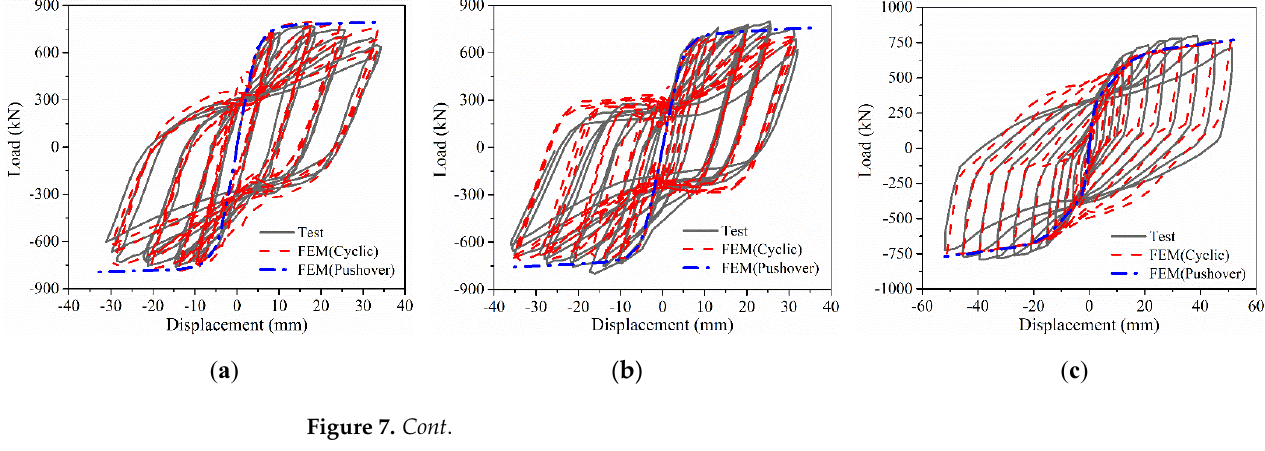
Figure 6. Specimen finite element model: ( a ) SPSW − HS2; ( b ) SPSW − HS; ( c ) DS − PSW; ( d ) DS − SPSW; ( e ) Frame.